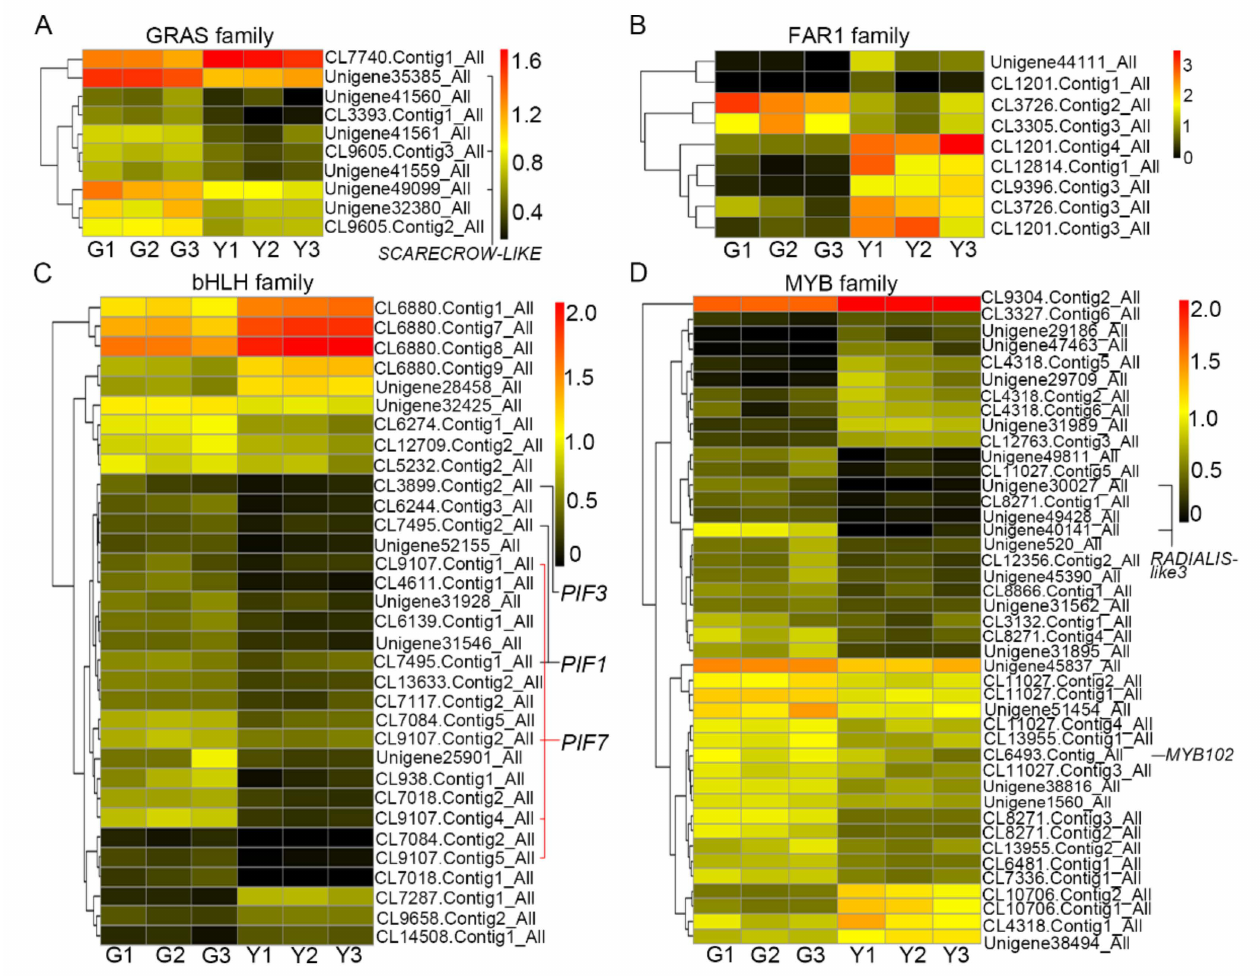
Figure 5. Summary of unigenes that may contribute to chlorophyll deficiency. Heat map showing the expression pattern of unigenes from the GRAS ( A ), FAR1 ( B ), bHLH ( C ), and MYB ( D ) families in green and yellow tissues. G1–G3: three biological replicates for green tissues; Y1–Y3: three biological replicates for yellow